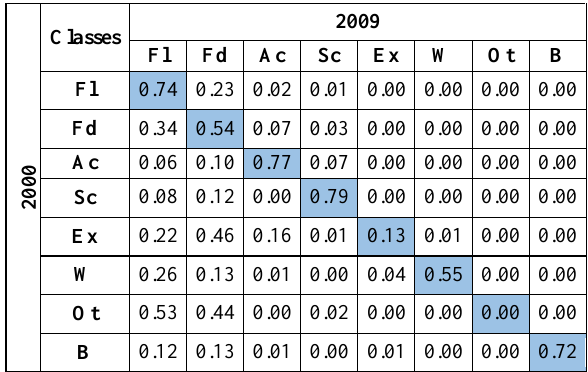
Table 7. Matrix of transition between 2009 to 2019.